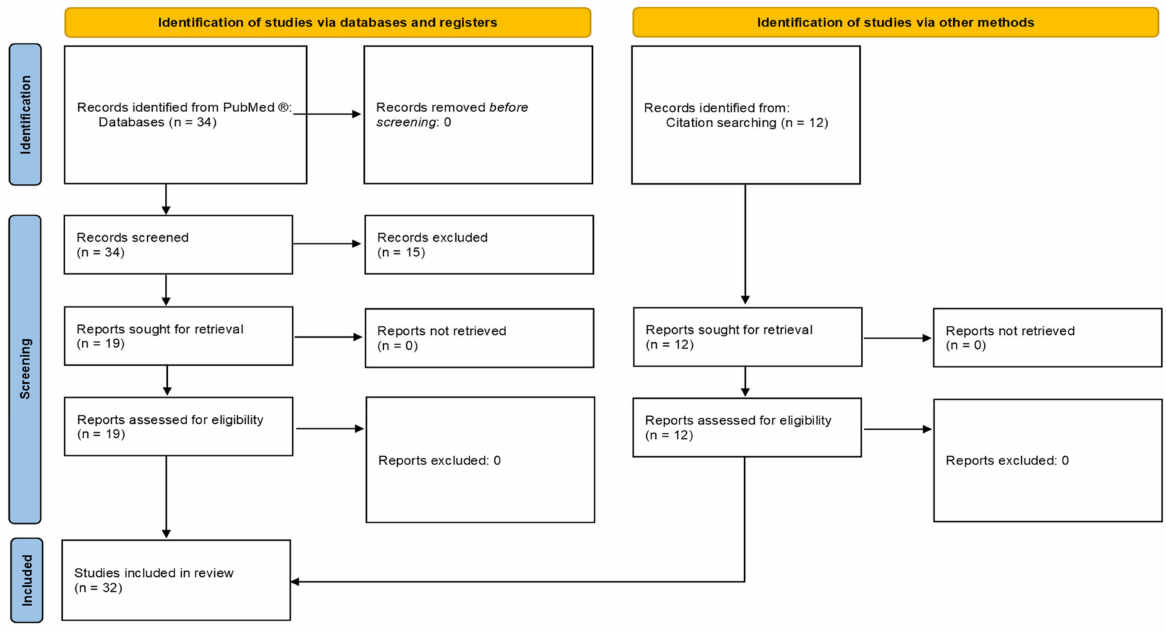
Figure 1. PRISMA 2020 flow diagram of study